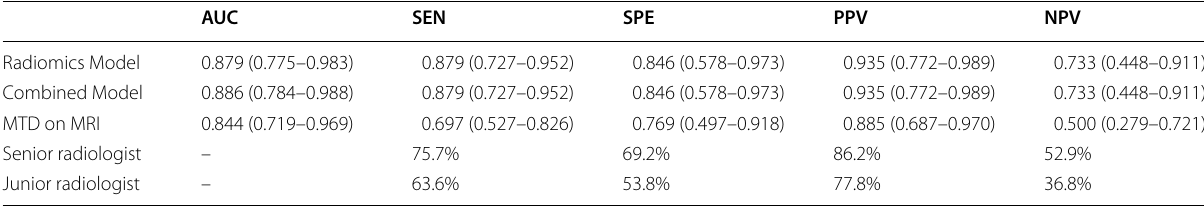
Table 3 Diagnostic performance of radiomics model, combined model, MTD on MRI, and radiologists in validation cohort